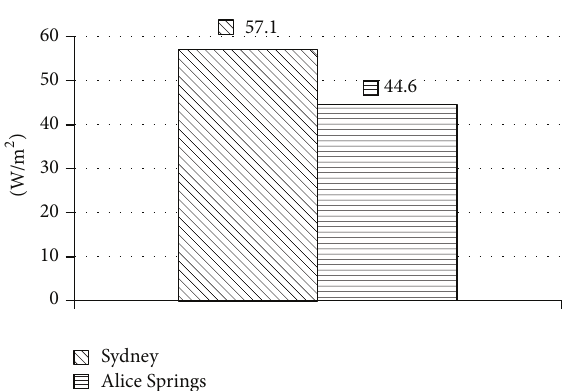
Figure 4: Water cooling with nocturnal cooling effect in Alice Springs using the system described in this work.